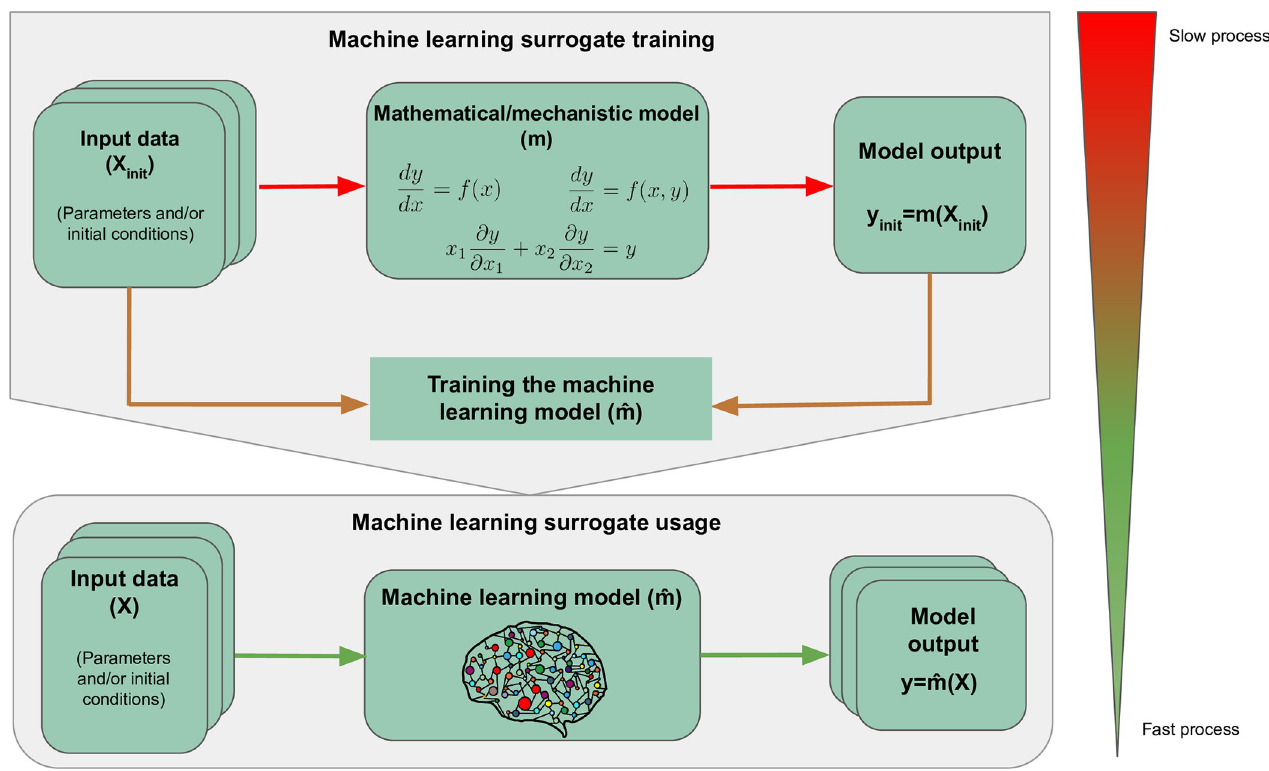
Fig 1. Schematic representation for training and using an ML-based surrogate model. The mechanistic model is simulated (the top process connected by red arrows) to obtain the input-output pairs that are used to train the ML surrogate. This training stage (the middle process connected by orange arrows) is an average process in terms of speed. Its complexity will depend on the ML algorithm used, the complexity of the data preprocessing steps, and the quantity of training iterations needed to obtain a satisfactory accuracy. Once this is achieved, the ML model can be used for all future predictions, effectively approximating the mechanistic model while running several orders of magnitude faster. The green arrows at the bottom of the figure represent this final (fast) process.